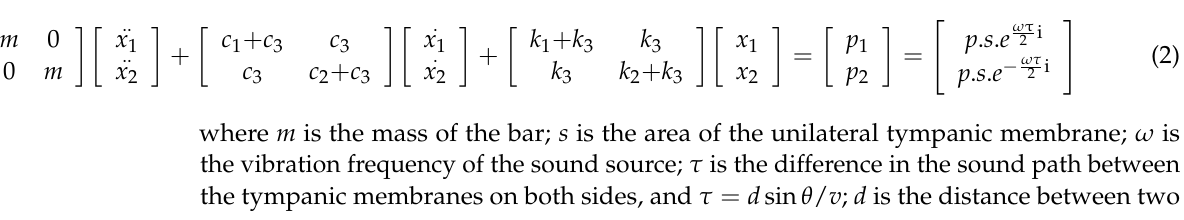
Parameters listed in Figure 2 mean: k 1 and k 2 : translation spring; c 1 and c 2 : translation dashpot; k 3 : torsional spring; c 3 : torsional dashpot; p : sound wave pressure at the pivot point; θ : The angle of the incident direction of the sound wave and the body axis of O. ochracea ; p 1 and p 2 : The left and right sound pressure signals; x 1 and x 2 : The left and right sound pressure signals; d : The distance between two tympanic